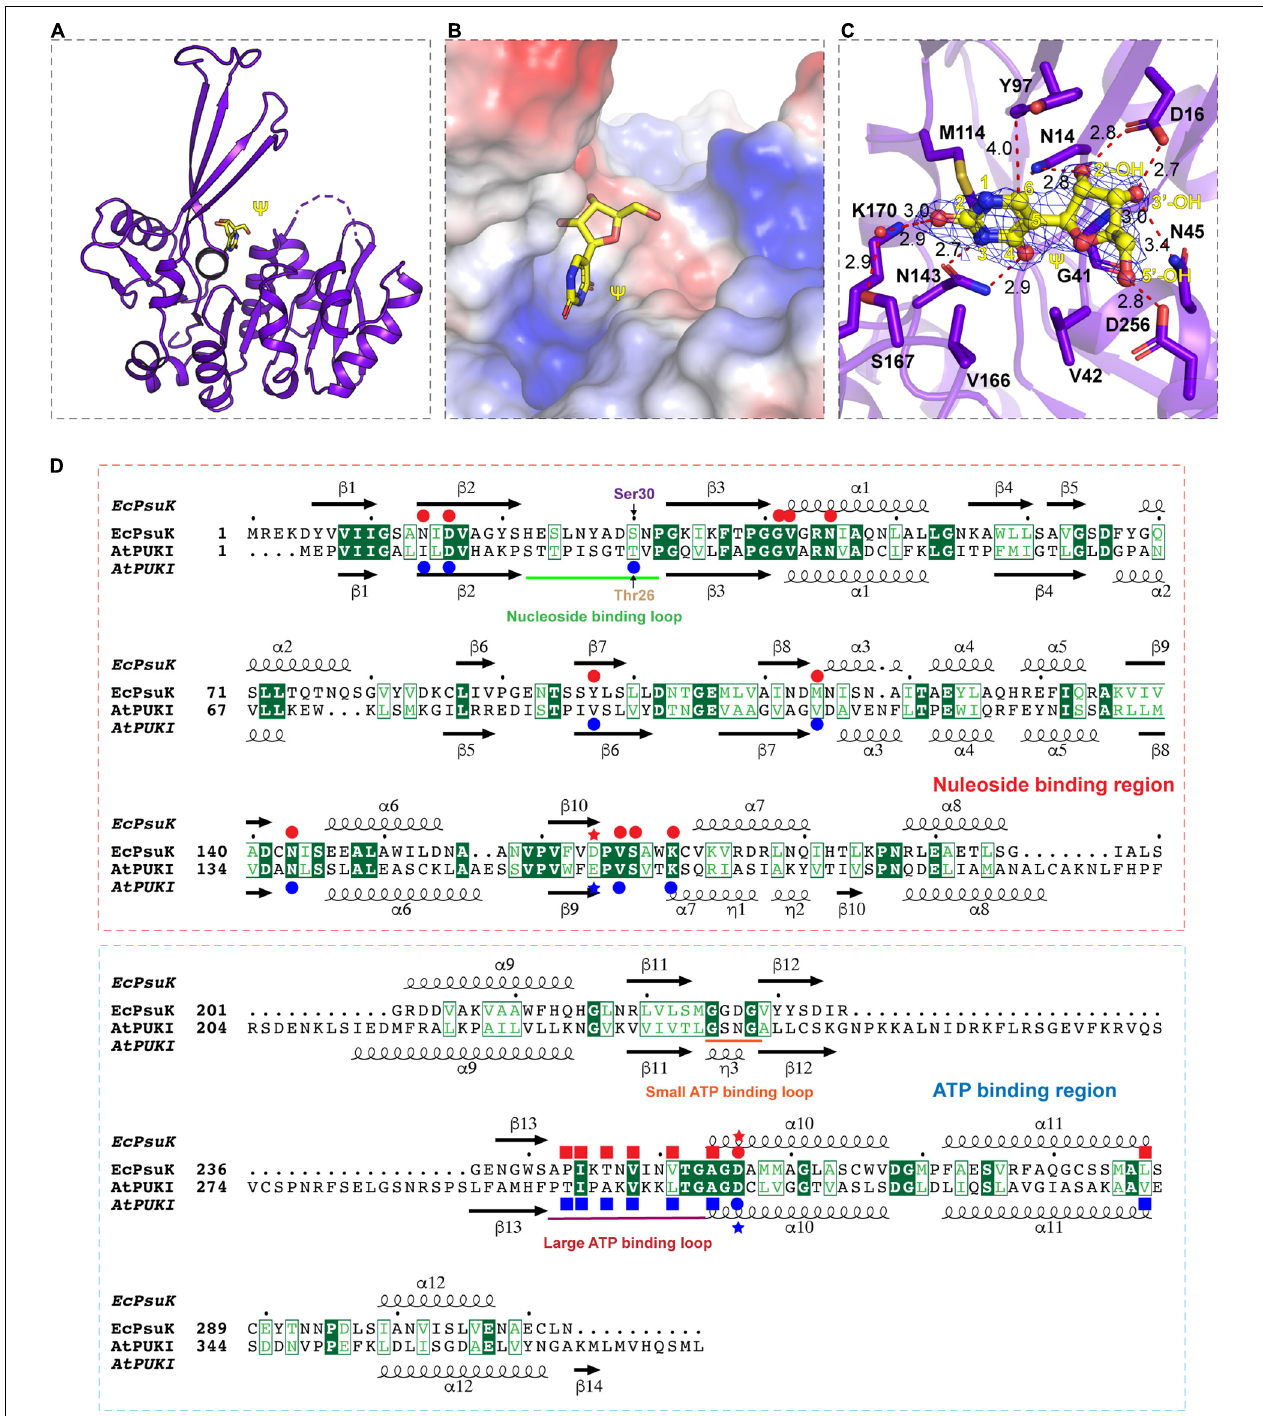
FIGURE 3 | Complex structure of Ec PsuK with (cid:57) . (A) Overall structure of Ec PsuK in complex with (cid:57) . Ec PsuK is shown as cartoon and colored in purple, and (cid:57) is shown as the stick and colored in yellow. (B) Substrate-binding surface underneath the β -thumb region and above the α / β fold region. (C) Detailed interactions between Ec PsuK and (cid:57) . Ec PsuK is shown as cartoon and colored in purple, the residues in contact with (cid:57) are shown as sticks, and (cid:57) is shown as stick colored in yellow. The hydrogen bonds are shown as red dashed lines. The red sphere represents the water molecule. The 2| Fo| –| Fc| σ -weighted map is contoured at 1.5 σ . (D) Structure-based sequence alignment between At PUKI and Ec PsuK. The residues involved in substrate binding are indicated by red ( Ec PsuK) or blue ( At PUKI) circles, respectively. The residues involved in ATP binding are indicated by blue squares for At PUKI, and the red squares indicated the potential residues in Ec PsuK involved in ATP binding. The nucleoside-binding region and the ATP-binding region are indicated by red and blue rectangles, respectively. The red and blue stars indicate the residues that may involve in catalytic reaction.